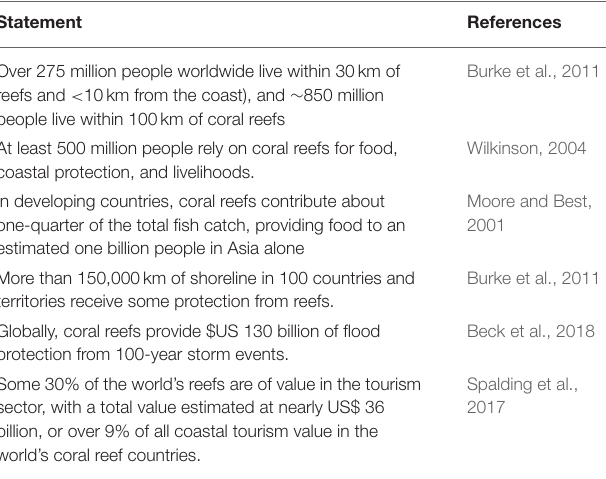
TABLE 1 | Values of coral reef ecosystem services quantified in the literature, from a global perspective.